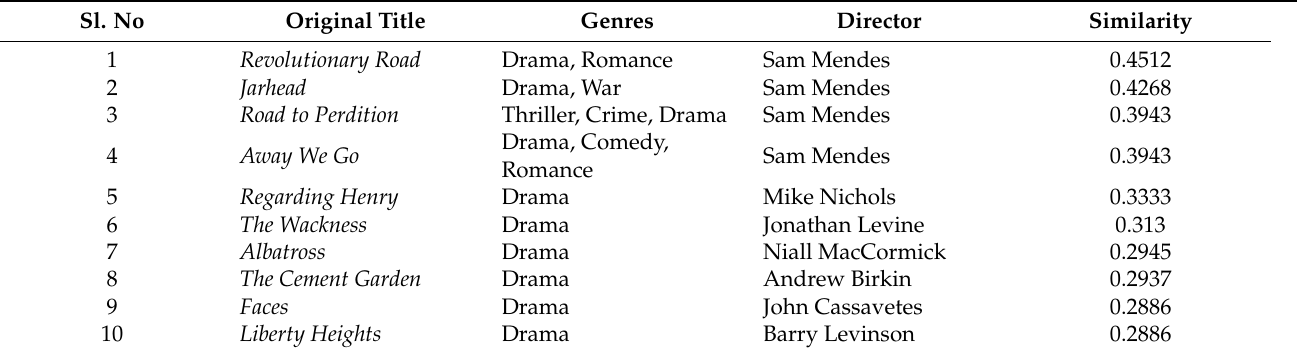
Table 8. Similar movies to the movie American Beauty .